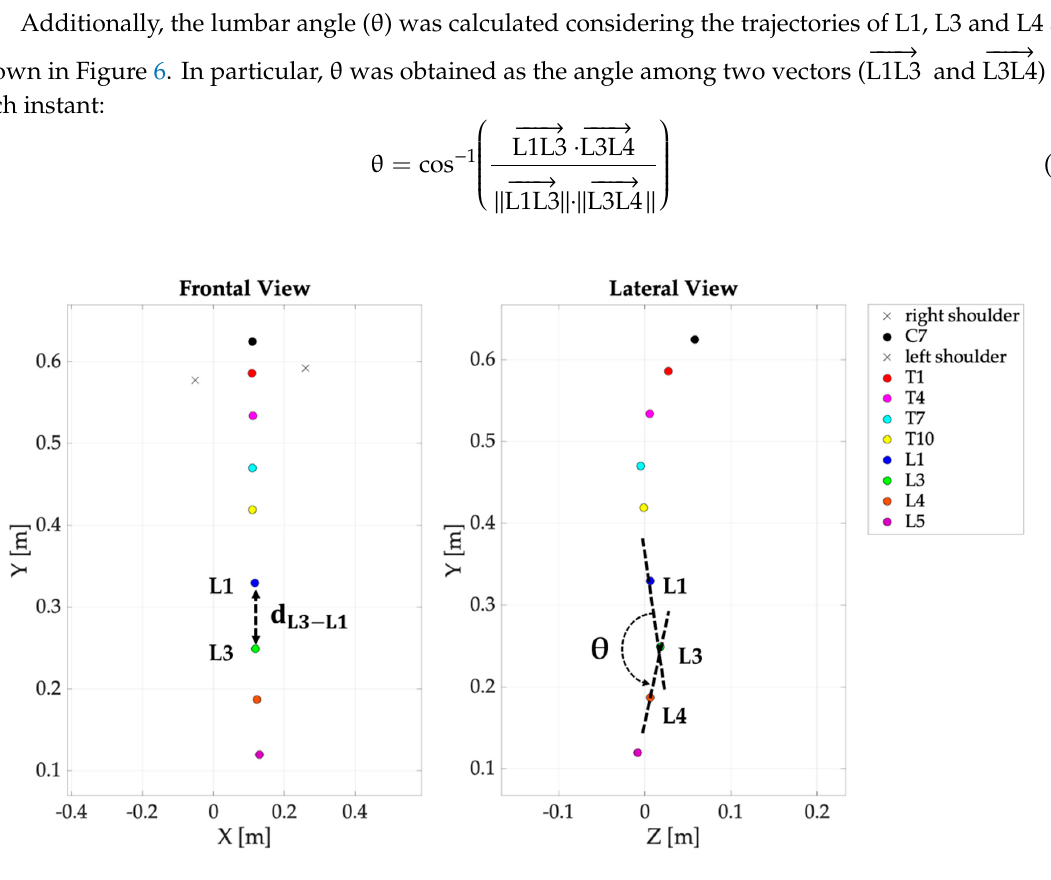
Figure 6. The distance d L3 − L1 ( left image ) and the lumbar angle θ ( right image ) retrieved from markers’ trajectories.